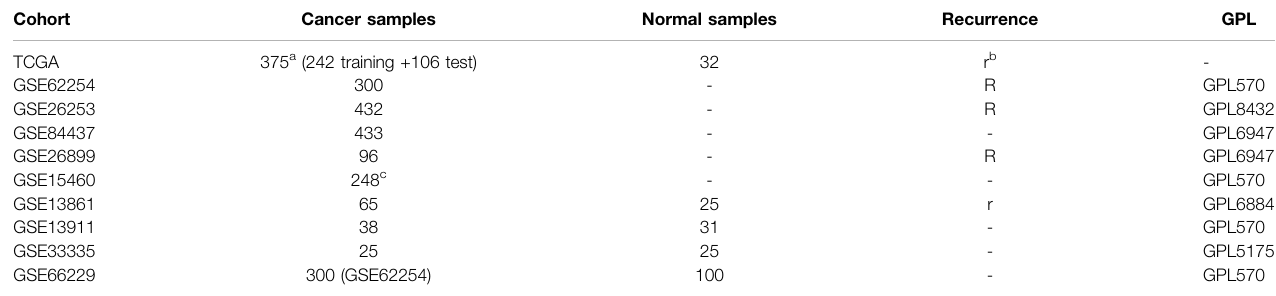
TABLE 1 | Patient cohorts from TCGA and GEO databases. Cohort Cancer samples Normal samples